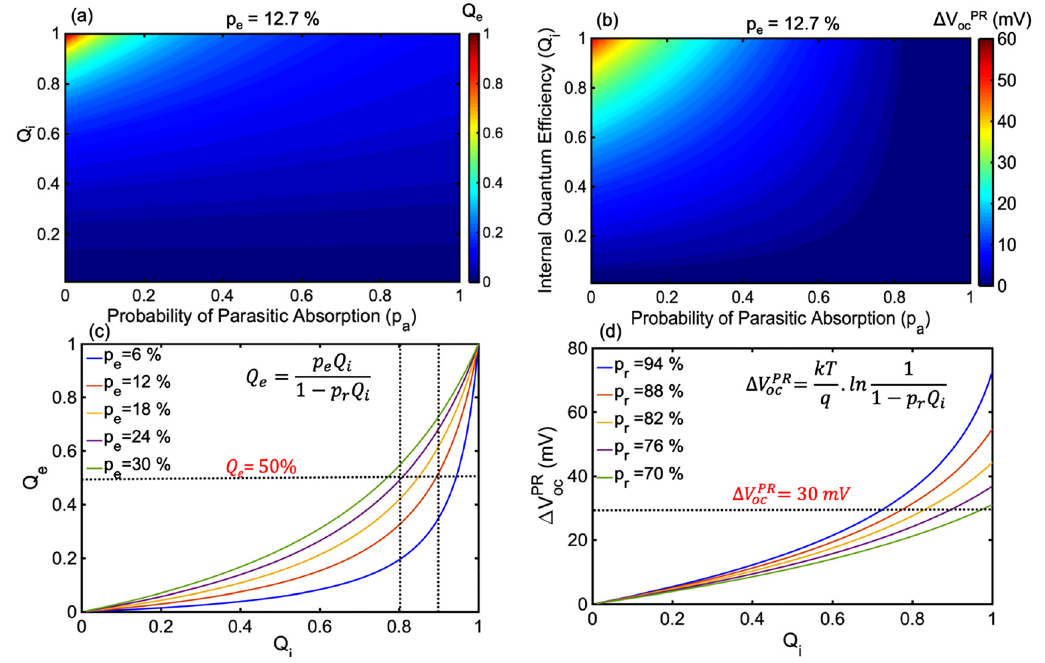
of PSCs. oc for various photon reabsorption probabilities p r oc